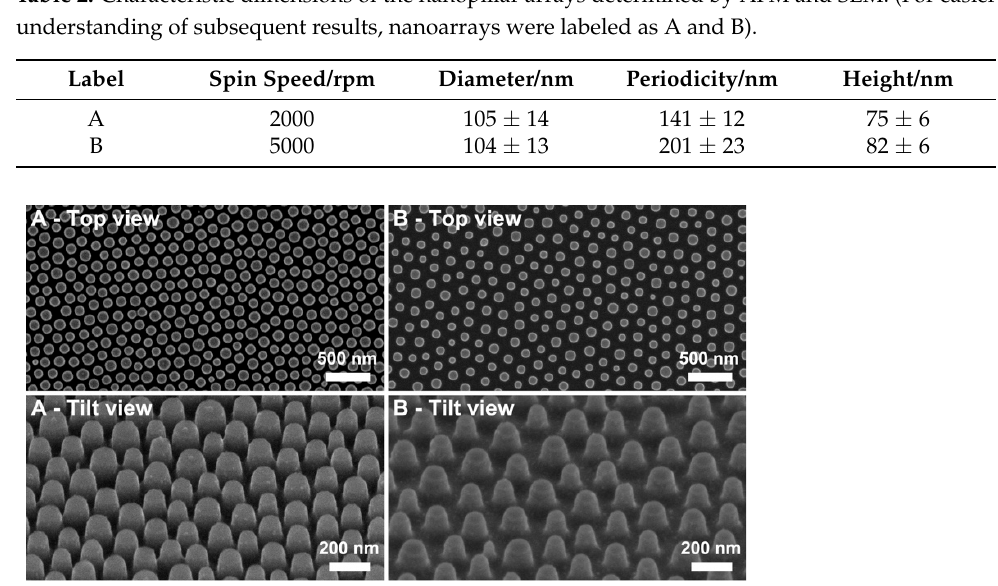
Figure 2. SEM images of the fabricated nanopillars at top and tilted views of nanostructures labelled as (A) and (B) as presented in Table 2.